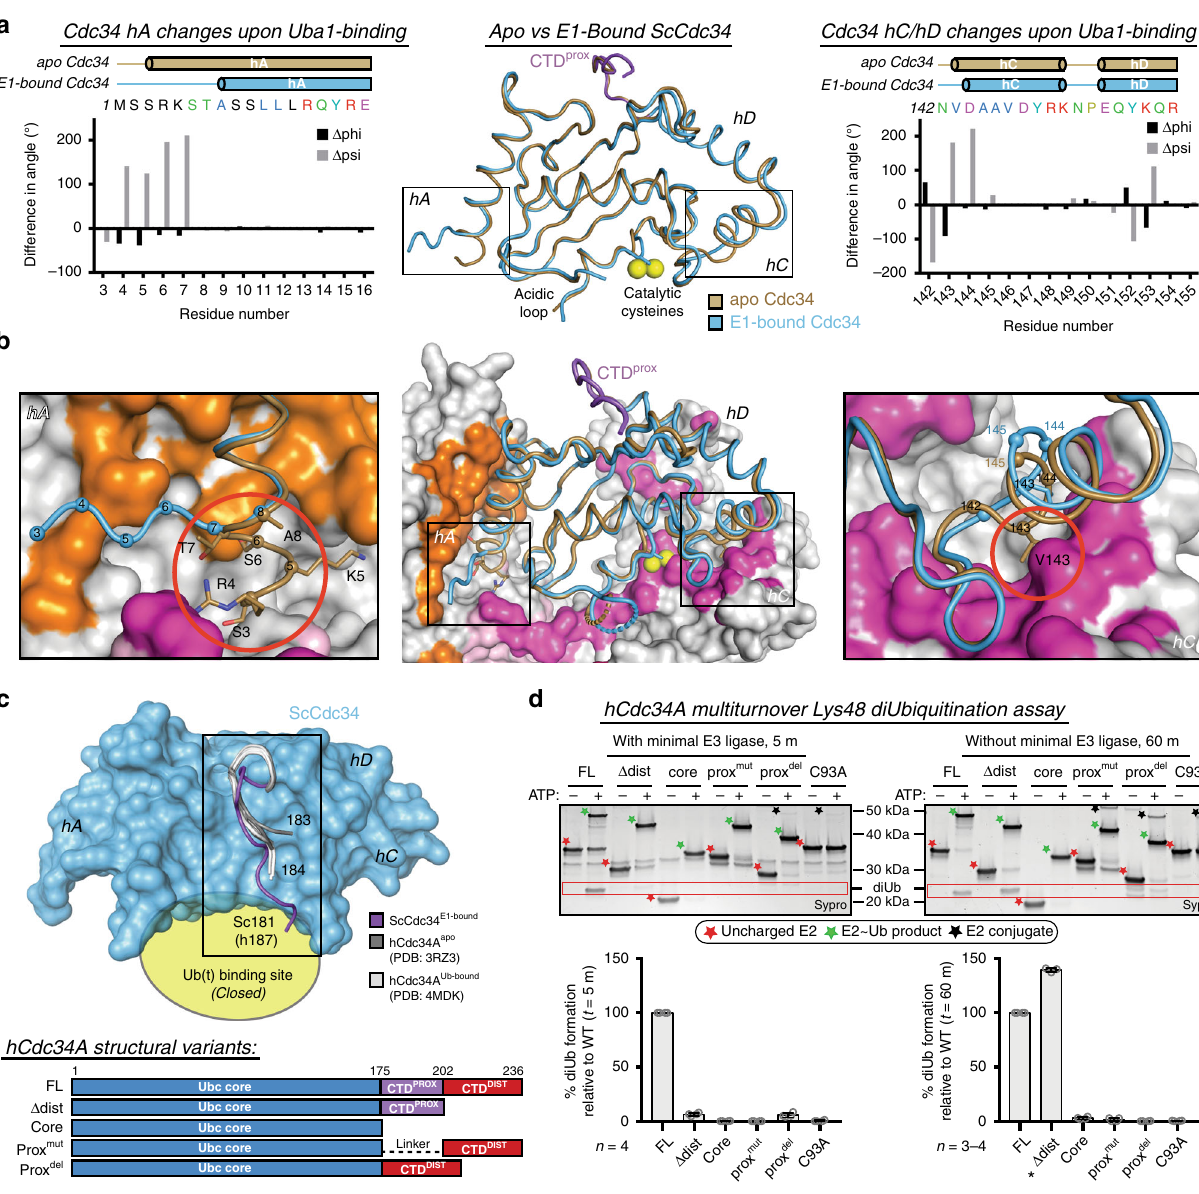
Fig. 5 Structural changes in key Cdc34 elements accompany E1 binding. a Middle , apo (tan) and E1-bound (blue) Cdc34 superimposed using the conserved core of the protein. hA and hC conformational changes are highlighted by black boxes. Differences in phi and psi angles between Cdc34 E1-bound and Cdc34 apo are shown as bar graphs for hA ( left ) and hC/hD ( right ). Cartoons above the graphs indicate secondary structure boundaries for Cdc34 apo (tan) and Cdc34 E1-bound (blue). b Middle , Cdc34 apo superimposed as in a onto Uba1 – Cdc34 complex. Uba1 is colored as in Fig. 1 and Cdc34 conformational changes are highlighted as in a . Zoomed in view of Cdc34 hA ( left) and hC ( right ) with clashes between Uba1 and Cdc34 apo indicated by red circles. c Top , top-down view of CTD prox of ScCdc34 E1-bound (purple), hCdc34A apo (PDB:3RZ3, dark gray), and hCdc34A Ub-bound (PDB:4MDK, light gray) superimposed as worms with ScCd34 core shown as blue surface, and closed Ub(t)-binding site indicated by a yellow oval. Bottom , cartoon schematic of hCdc34A global mutants used for K48-diUb assays. d K48-diUb assays for the indicated mutants with ( left ) and without ( right ) minimal E3 ligase. Data are represented by mean ± SD with individual replicates shown as gray circles. Biochemical assays have four independent replicates, unless indicated by an asterisk when there are three replicates. Representative replicates are labeled above and annotated with stars for clarity. diUb product is indicated by a label and red box. Source data are provided as a Source Data fi